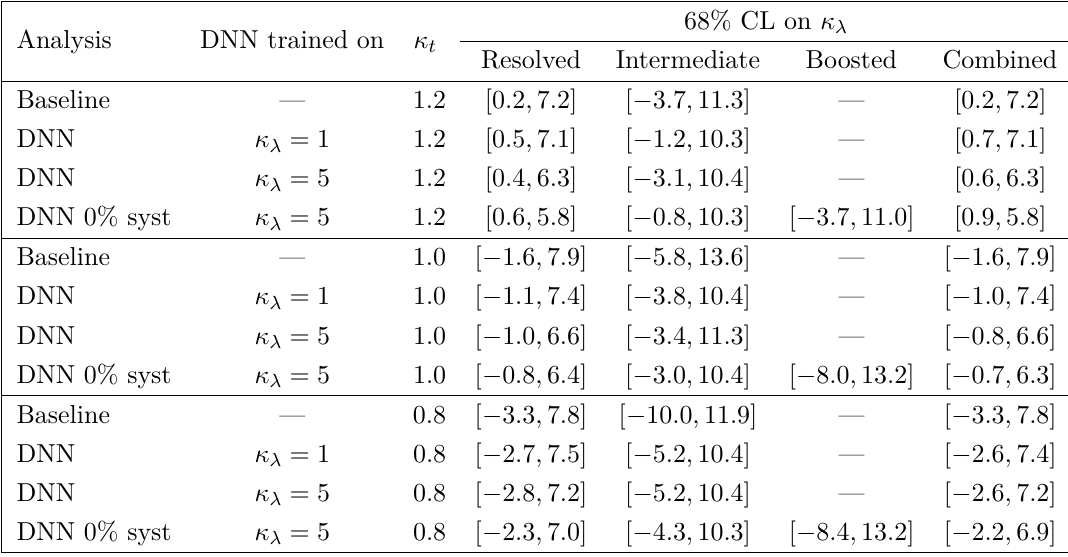
Table 8. Summary of 68% CL limits on κ λ for baseline analysis and neural network analysis (DNN) by separate categories and combined. These are shown for κ t = 1 . 2 , 1 . 0 , 0 . 8 to demonstrate the impact of uncertainties on the top Yukawa. Systematic uncertainties on the background of 0.3%, 1% and 5% are assumed for the resolved, intermediate and boosted categories, respectively. The DNN analysis trained on κ λ = 5 is also shown with 0% systematics for comparison. A ‘—’ in the 68% CL columns indicates no constraint in the range of κ λ considered, κ λ ∈ [ − 20 , 20]